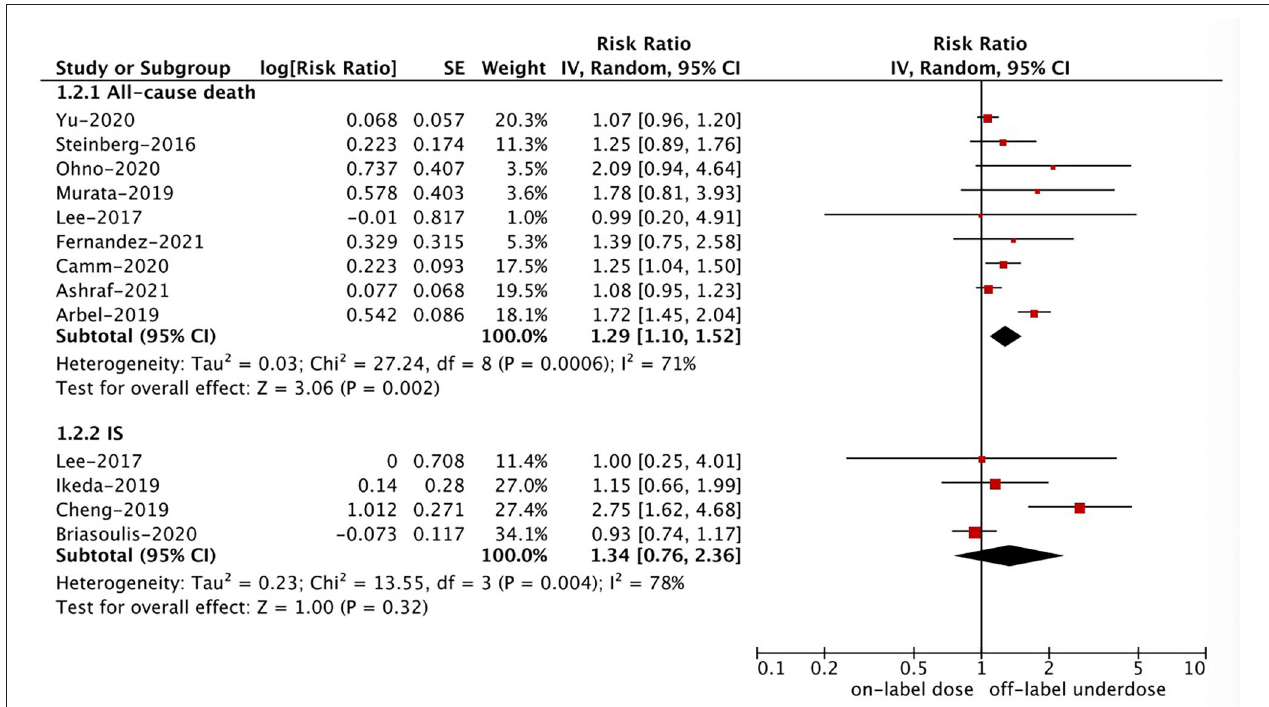
FIGURE 3 | A random-effects model for comparing the outcomes between off-label underdose and on-label dose of NOACs in patients with atrial fibrillation. NOACs, non-vitamin K antagonist oral anticoagulants; IS, ischemic stroke; CI, confidence interval; SE, standard error; IV, inverse of the